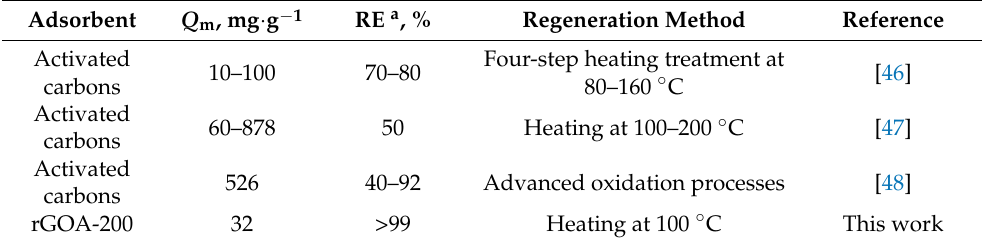
Figure 11. Adsorption breakthrough curves for L2 of rGOA-200 in the repeated cycles. Table 4. Adsorption and regeneration capacities of different carbon materials for